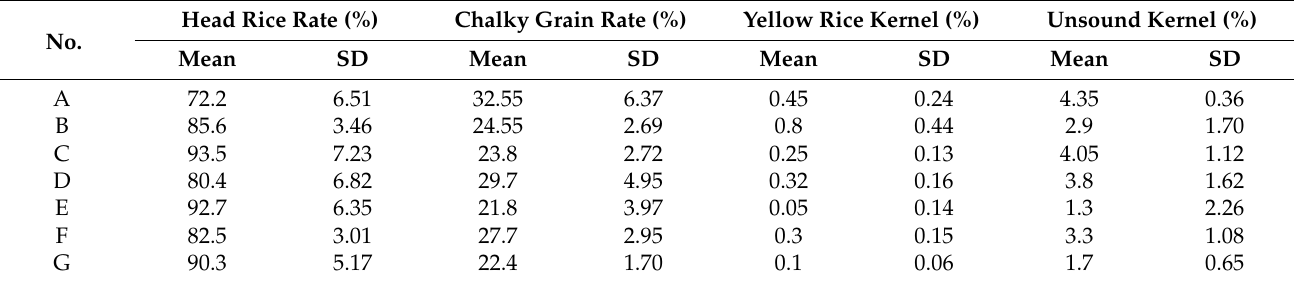
Table 2. Appearance quality testing of paddy after different drying